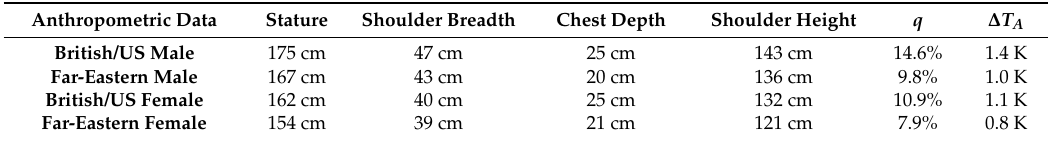
Table 4. Filling factor estimation and correspondent ∆ T A for a single stationary British/US and Far-Eastern human body (male and female) positioned at the beam centerline. Anthropometric data: 50th percentile, age: 19–65 years [29]. Antenna parameters: β = 30 ◦ , vertical pointing, D = 3 m. T s , T env and T bkg as in Table 1, Experiment 3.